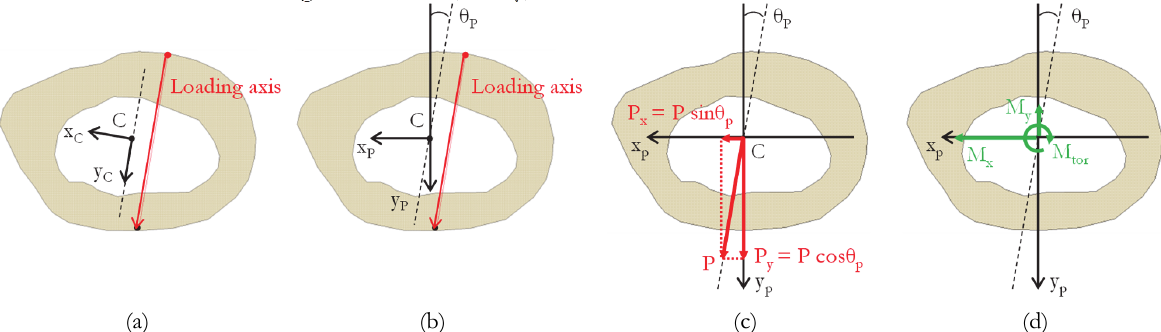
Figure 4: (a) The “imprint” of the cross-section of a typical bone, as it was obtained using the AutoCAD software; (b) The centroid of the cross-section and the eccentricity of the loading axis; (c) The thickness measured in various locations of the cross-section in order to determine the cortical bone’s average thickness and, finally, the area needed for the calculation of the shear stress.